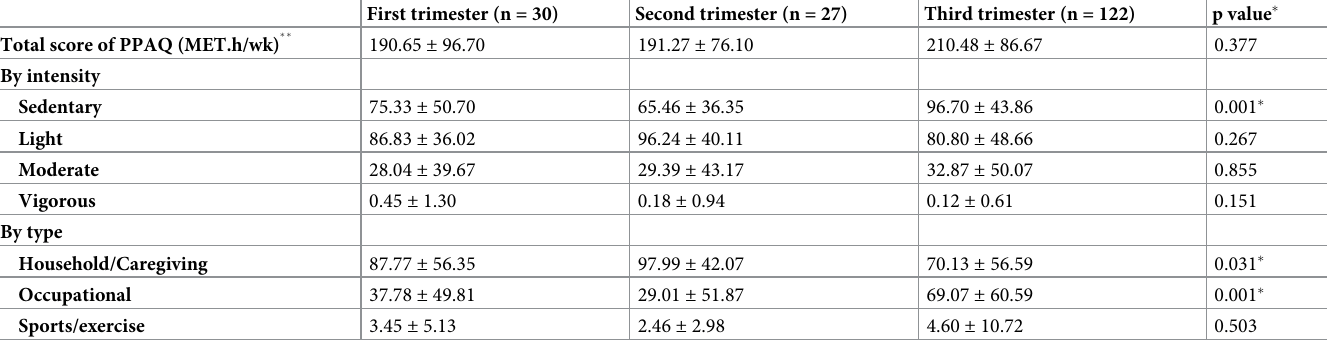
Table 3. Type and intensity of PA, deducted from the PPAQ, in women categorized depending on their gestational trimesters (N = 179). Total score of PPAQ (MET.h/wk)